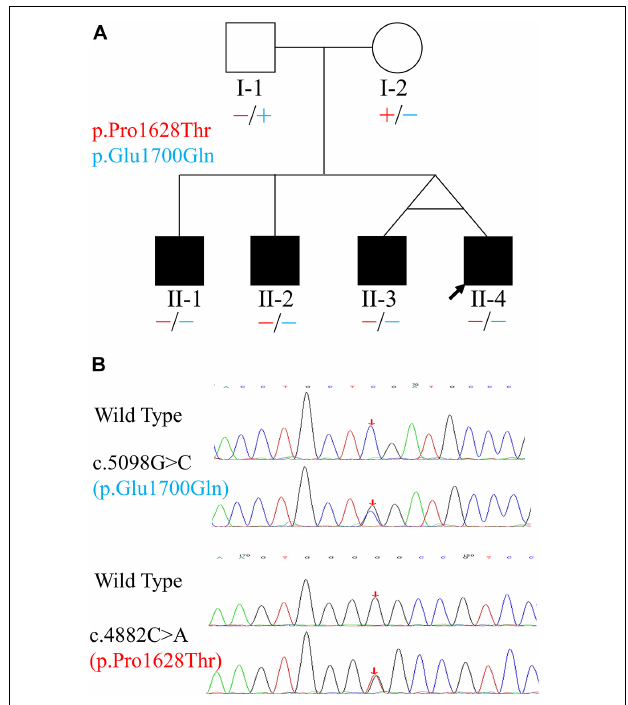
FIGURE 1 | Pedigree and variants of the OTOF gene found in the family. (A) Pedigree and distribution of OTOF variants. Filled symbols represent affected individuals. Circle indicates female and squares indicate males. The two variants are shown in different colors. “–“ and “+” represent variant and wild-type OTOF , respectively. (B) Electropherograms showing the two heterozygous OTOF variants (in the reverse direction). The positions of variants are indicated by red